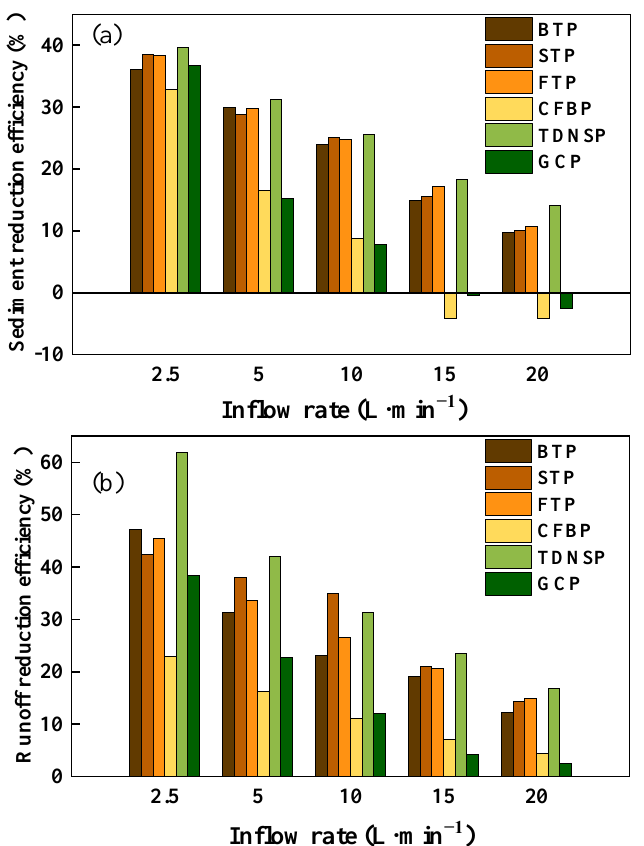
Figure 10. Effectives of seven measures on highway slope. ( a ) RRB of different measures. ( b ) SRB of different measures.